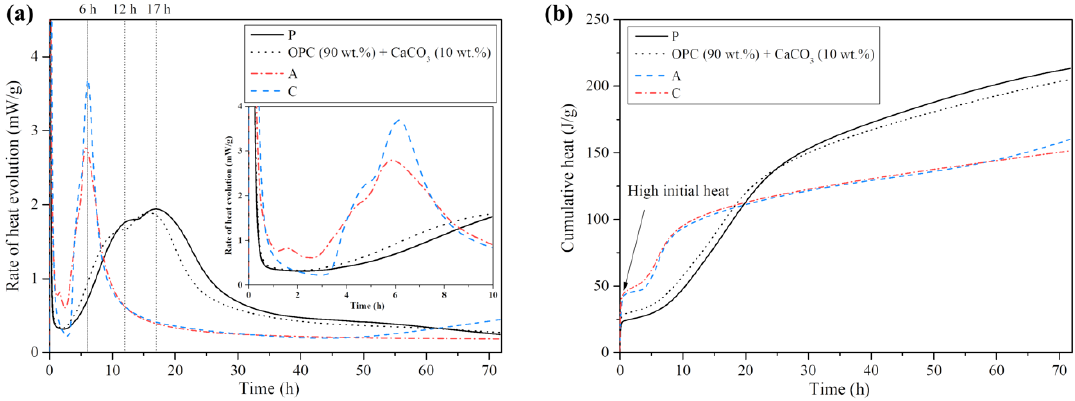
Figure 1. Heat of hydration of P, A and C for 72 h: ( a ) Rate of heat evolution; ( b ) Cumulative heat.